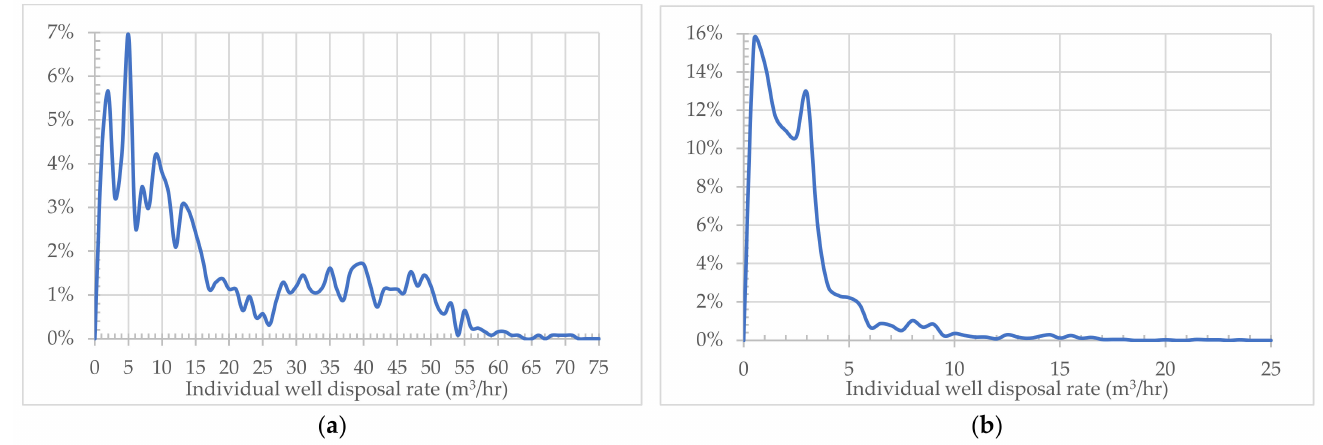
Figure A5. Historical per-well water injection rate ( X -axis) frequency ( Y -axis) distributions (January 1962–December 2022) in ( a ) the McLaren Formation; ( b ) the Notikewin Formation.